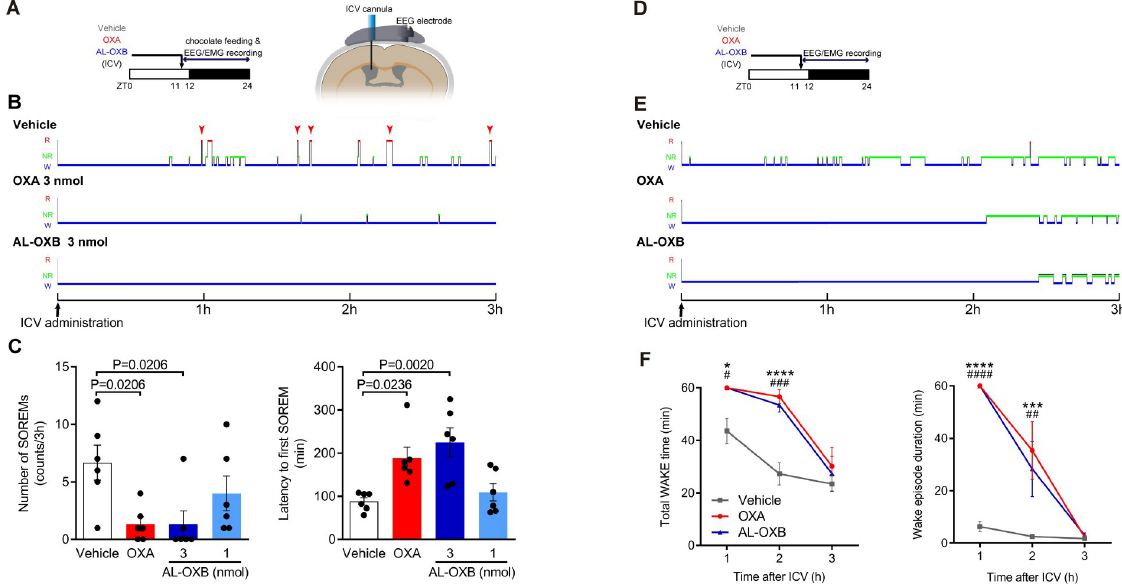
Fig 2. ICV AL-OXB prevents both cataplexy-like episodes and fragmentation of wakefulness in OXKO mice. (A) Experimental schedule (left) and surgery design (right). (B) Representative hypnograms showing the effect of ICV OXA or AL-OXB on cataplexy-like episodes in OXKO mice. R, REM state; NR, non-REM state; W, wake state. Red arrows: cataplexy-like states. (C) The number of cataplexy-like states during 3h (left) and latency to first cataplexy-like state (right) after ICV administration. Data represent the means ± SEM from 6 mice. Statistical analysis: one-way ANOVA followed by Bonferroni’s multiple comparisons test. (D) Experimental schedule for evaluation of wakefulness fragmentation. (E) Representative hypnograms showing the effect of ICV OXA or AL-OXB on wakefulness fragmentation in OXKO mice. (F) Hourly plots of wake time (left) and wake episode duration (right) during 3 h after ICV administration. Data represent the means ± SEM from 6 mice. � p < 0.05, �� p < 0.01, ���� p < 0.0001 for OXA vs. vehicle; #p < 0.05, ##p < 0.01, ####p < 0.0001 for AL-OXB vs. vehicle; two-way repeated-measures ANOVA followed by Bonferroni’s multiple comparisons test.